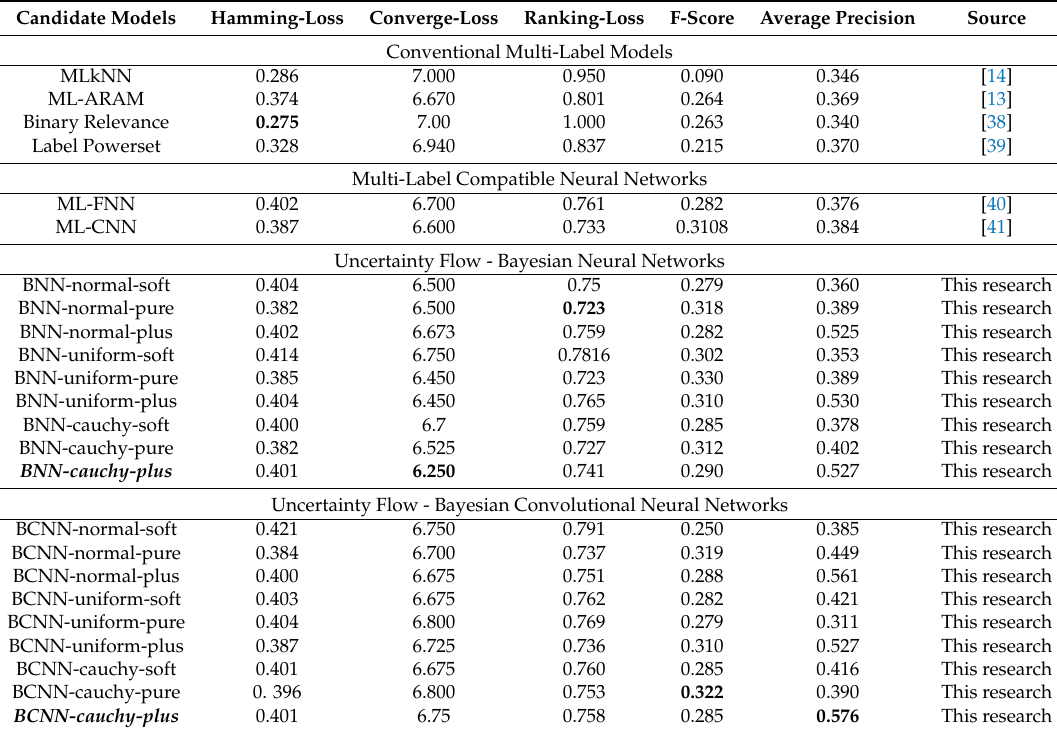
Table 1. Model Comparison in Various Multi-label Evaluation Metrics. Candidate